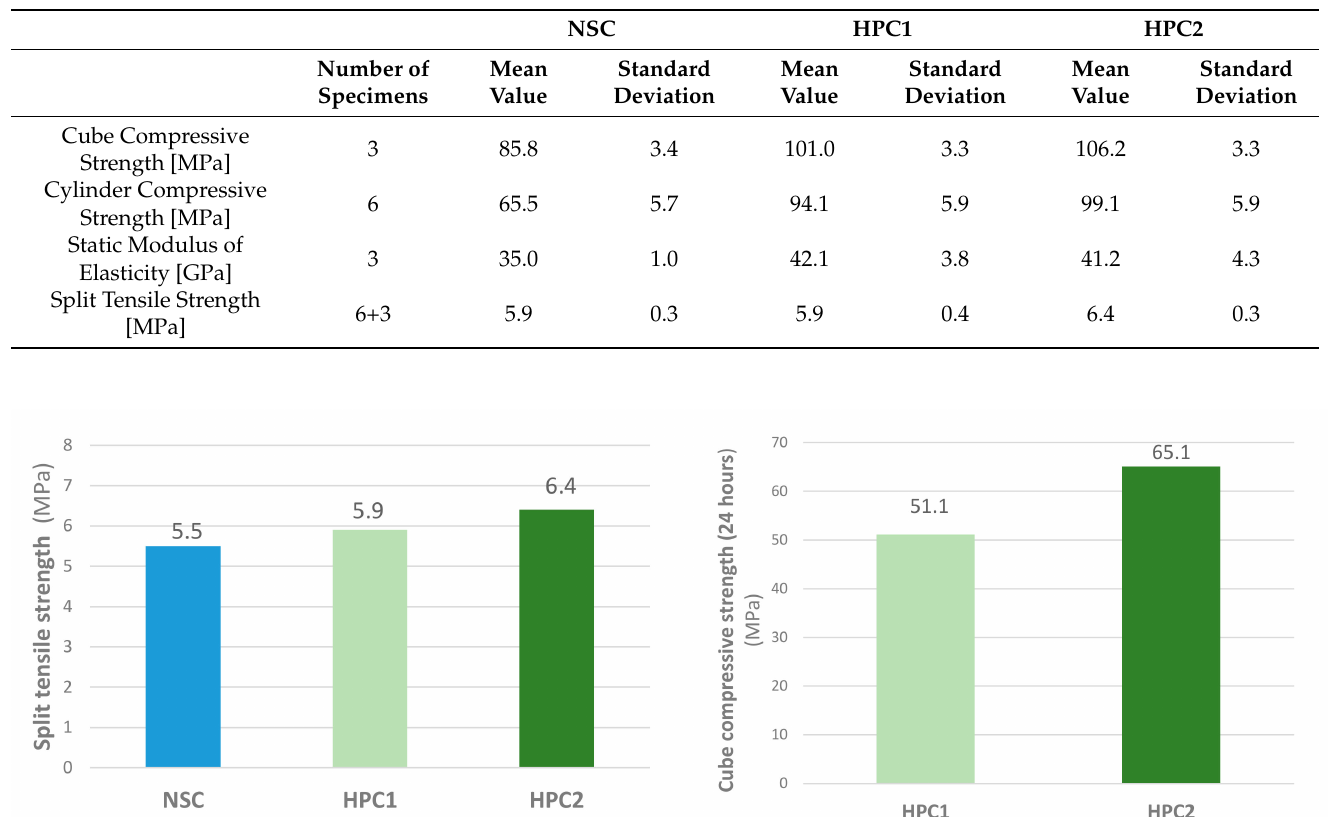
Table 2. Tested material characteristics.